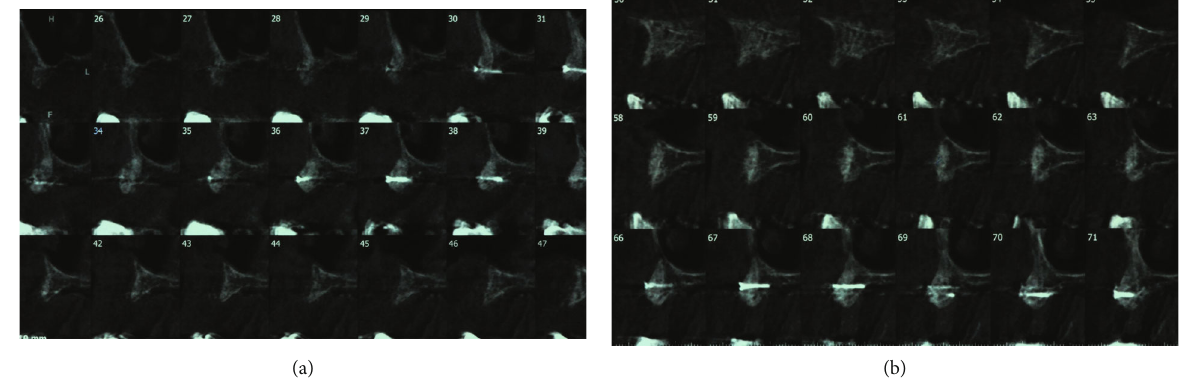
Figure 5: Sagittal view of CBCT images in case no. 2: (a, b) grafted areas 6 months postoperatively.